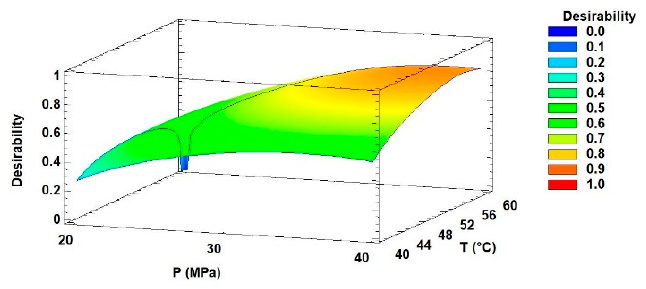
Figure 6. Surface of the desirability function in terms of pressure, temperature and maximum co-solvent (8% ethanol, v / v) obtained for maximizing extraction yield (Y), total carotenoids content (TCC) and recovery (TC recovery), phenol content (TPC), TEAC method, and FAMEs content from I. galbana.